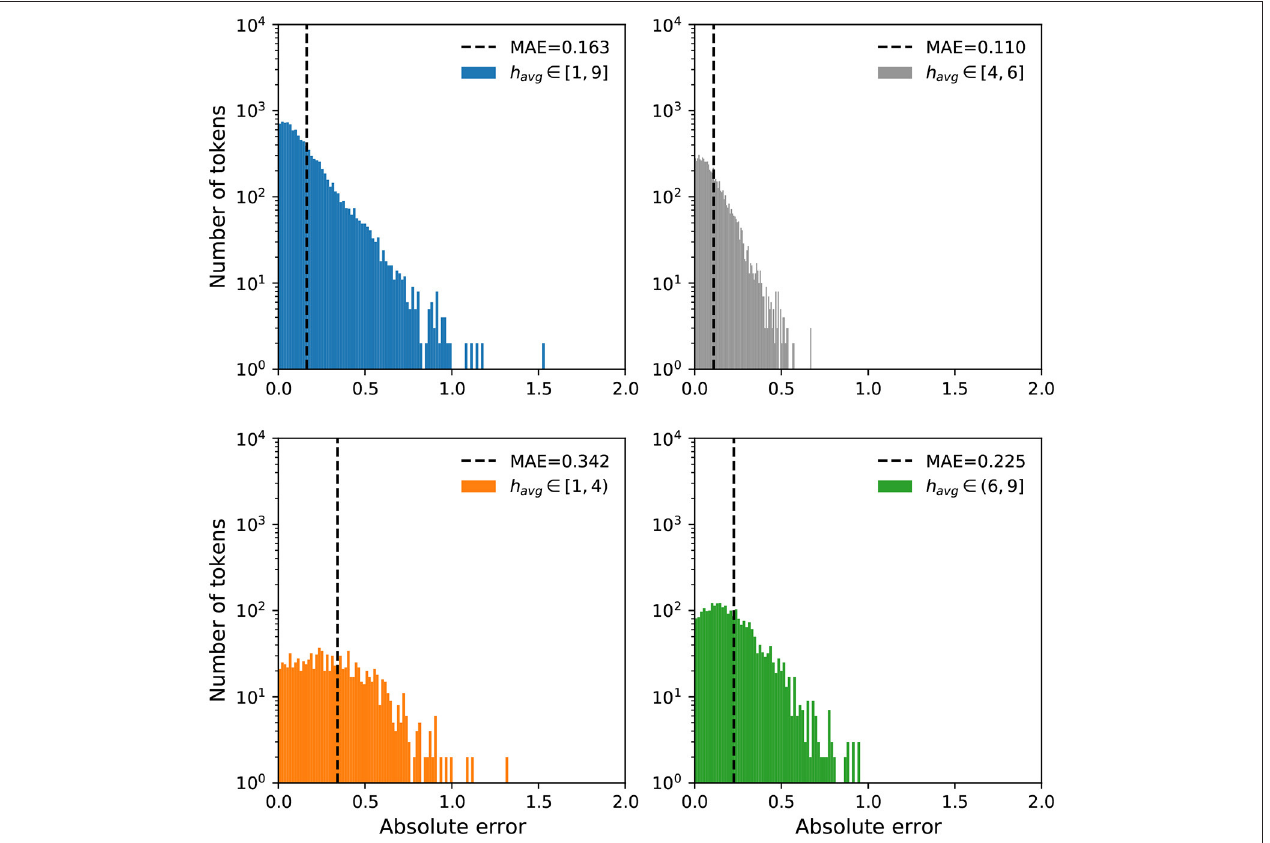
FIGURE 5 | Error distributions for the Token model. We display mean absolute errors for predictions using the Token model on all words in labMT. We arrange the happiness scores into three groups: negative ( h avg ∈ [1,4), orange), neutral ( h avg ∈ [4,6], gray), and positive ( h avg ∈ (6,9], green). Most words have an MAE less than 1 with the exception of a few outliers. We see a relatively higher MAE for negative and positive terms compared to neutral